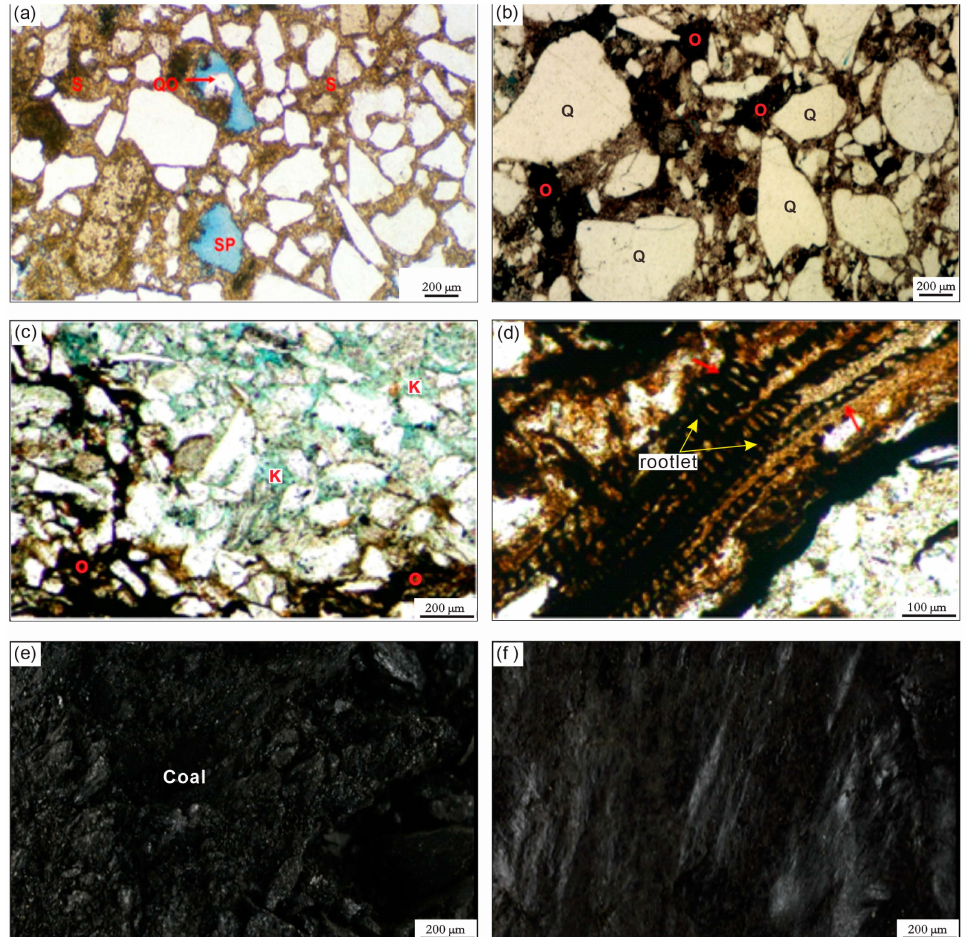
Figure 3. Photomicrographs of different petrographic features of the Mungaroo Formation in the NCB. ( a , b ) show the shapes and distribution patterns of the quartz (Q), feldspar (F), primary pores (P), sec- ondary pores (SP), and a small amount of siderite (S) and quartz overgrowth (QO), 4050.6–4051.0 m, well North orgon-1. ( c , d ) show the microscopic characteristics of quartz (Q), kaolinite (K), organic matter (O), and rootlets, 4035.4–4035.7 m, well Bluebell-1. ( e , f ) display the features of the coal